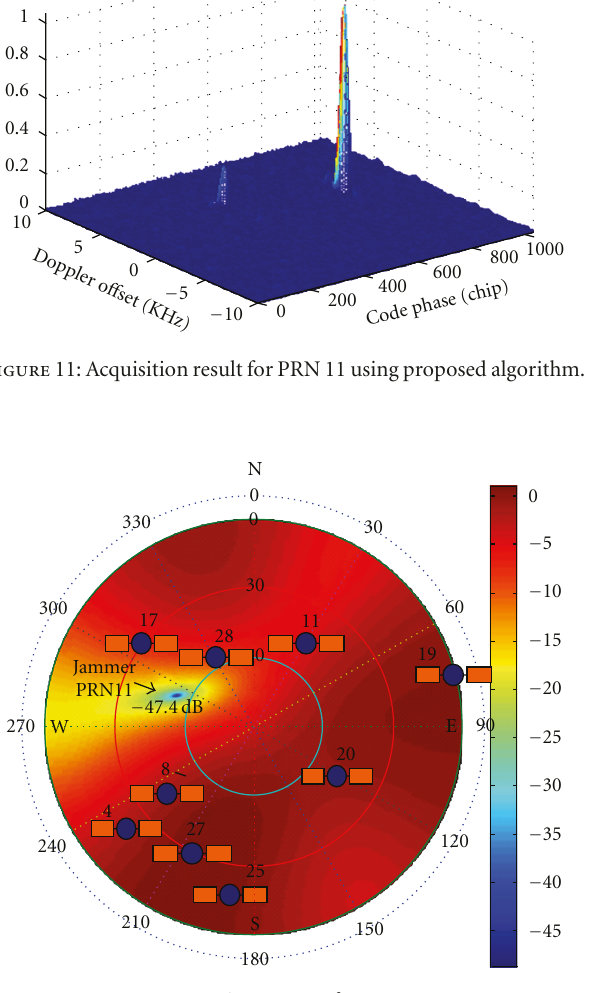
Figure 12: Gain pattern of antenna